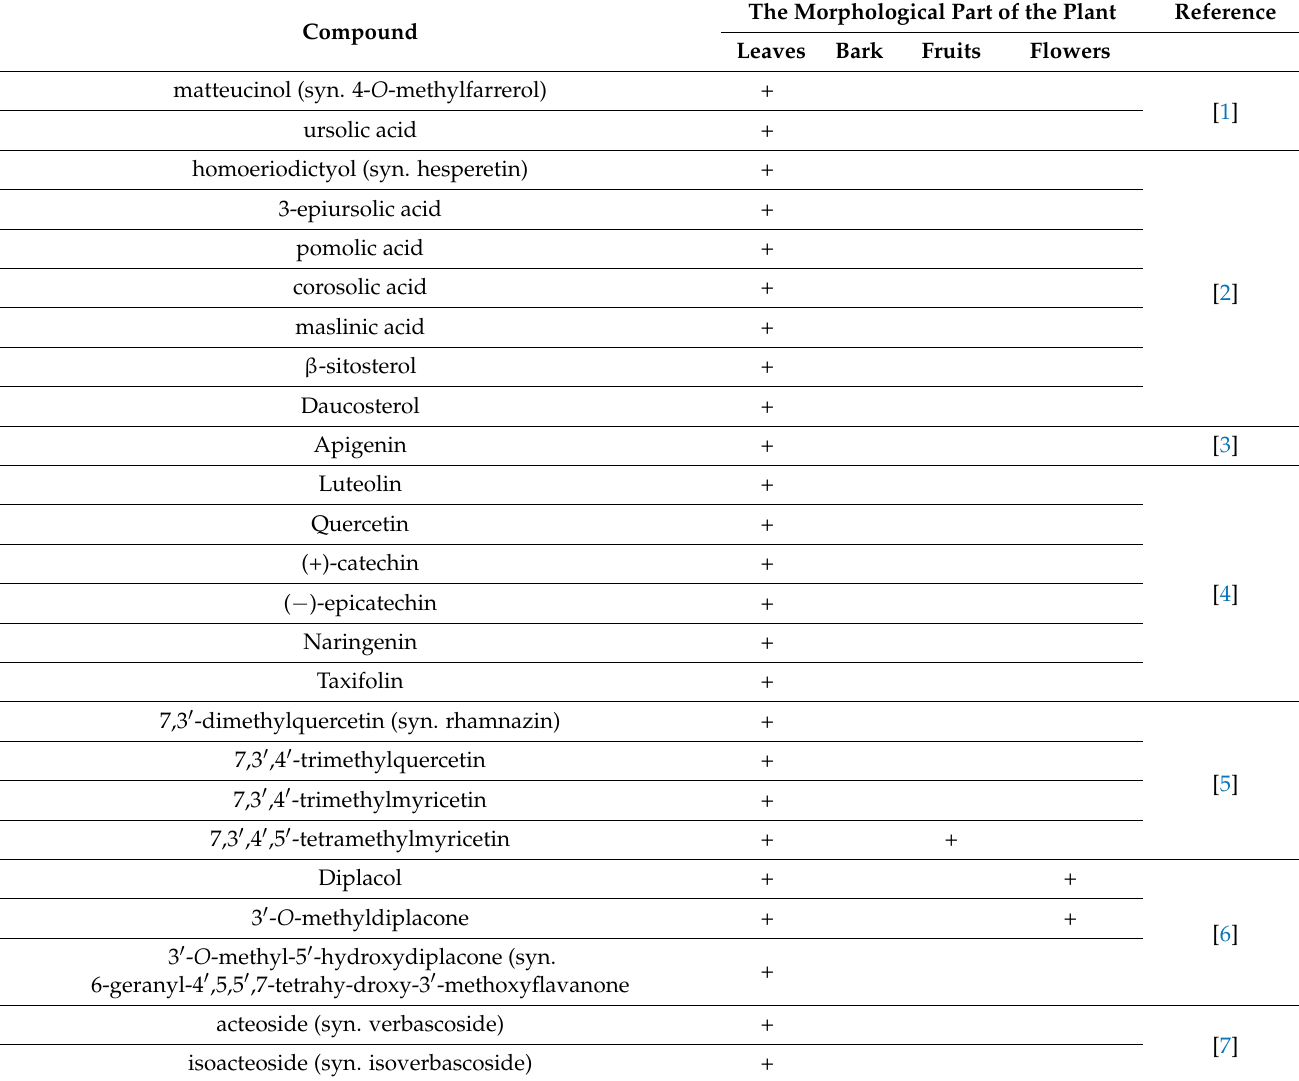
Table 1. Secondary metabolites found in the leaves, bark, flowers and fruits of Paulownia